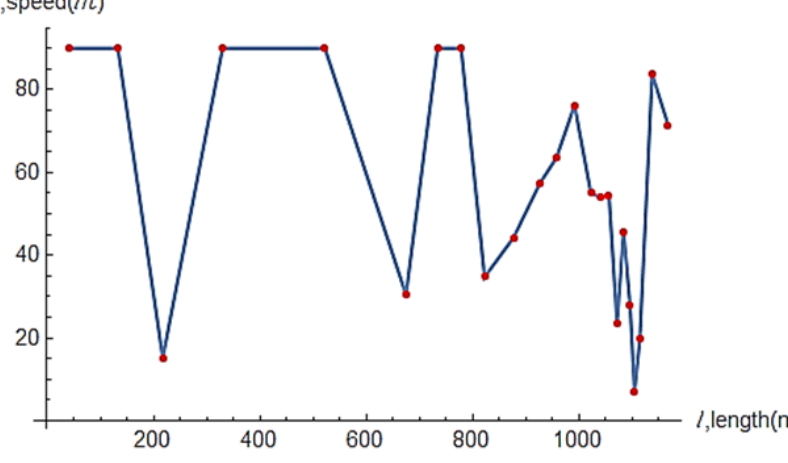
Figure 15. Design speed capped by average speed of 90 km/h.